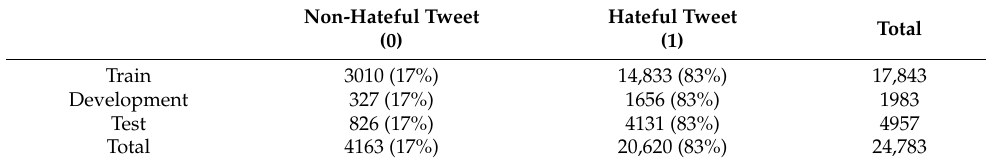
Table 3. Davidson dataset distribution of Non-hateful and Hateful